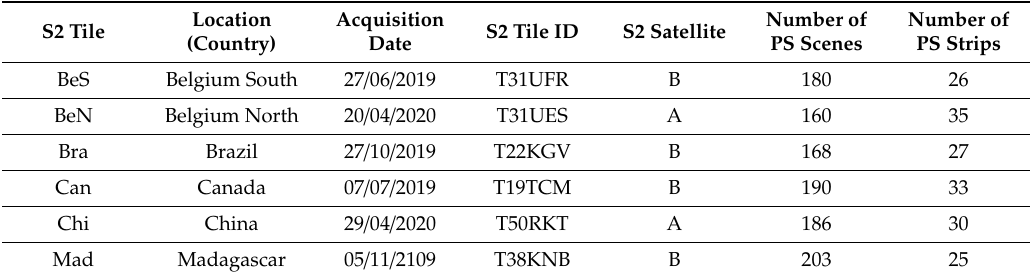
Table 1. Description of the six selected Sentinel-2 (S2) tiles (Figure 2). PS,